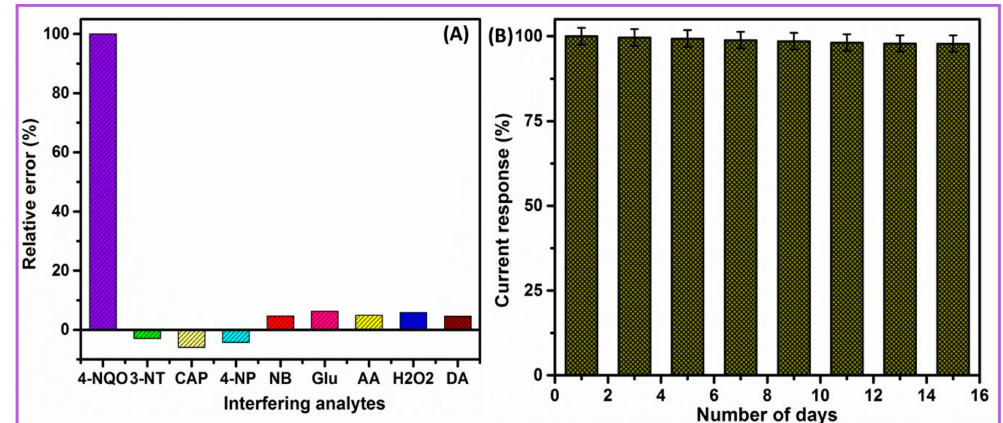
Figure 9. ( A ) Influence of interfering ions in 0.1-M pH 7 containing 0.5 µ M of 4-NQO and higher concentration of interfering analytes; ( B ) stability plot of NiCo 2 S 4 -Ms / GCE of its usage for 15 days.